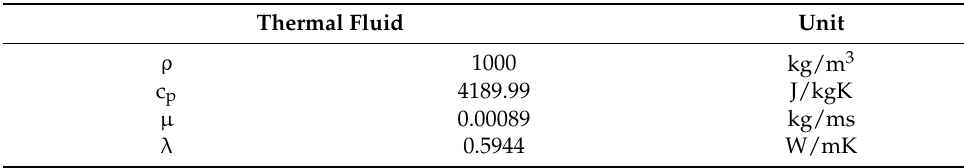
Table 6. Specific characteristics of the thermal fluid (Water).